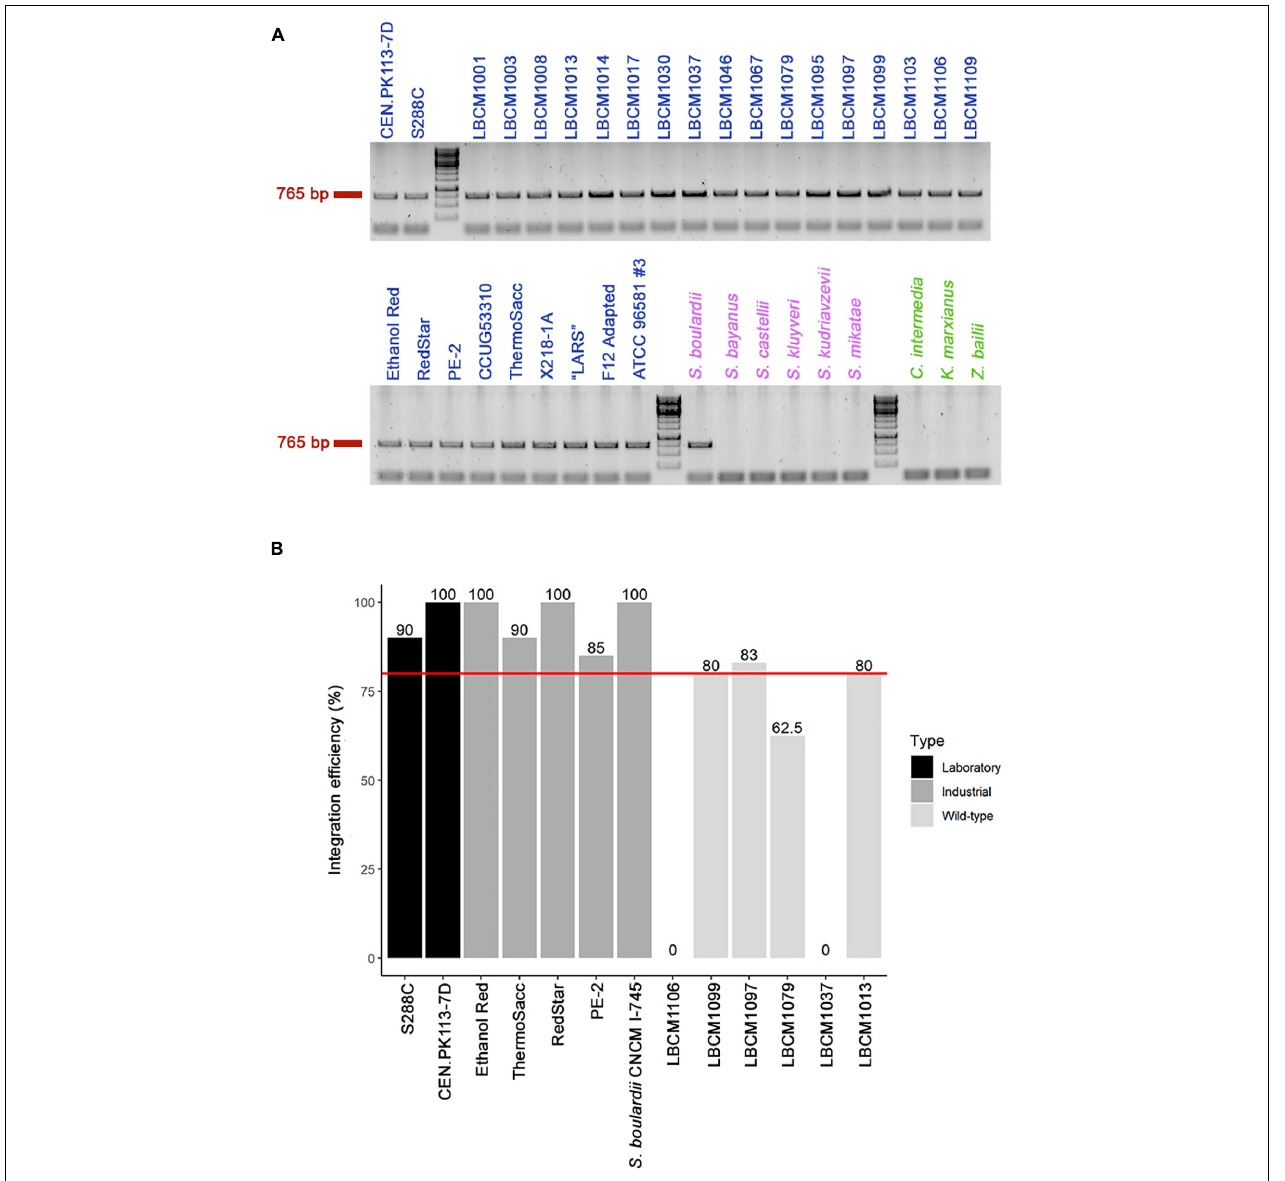
FIGURE 2 | Presence of the X2 site and genome integration efficiency. (A) Presence of the conserved X2 site (band at 765 bp) was verified by colony PCR in multiple yeast strains, including 28 Saccharomyces cerevisiae (blue), six other Saccharomyces (violet), and three non- Saccharomyces (green) strains (see Table 2 for a full list of yeast strains). (B) Assessment of genome integration efficiency in 13 of the 29 Saccharomyces (28 S. cerevisiae and 1 S. boulardii ) strains that harbored the X2 site was carried out using CRISPR-Cas9 genome editing technology. The red line represents 80% integration efficiency and the value for each strain is reported above the